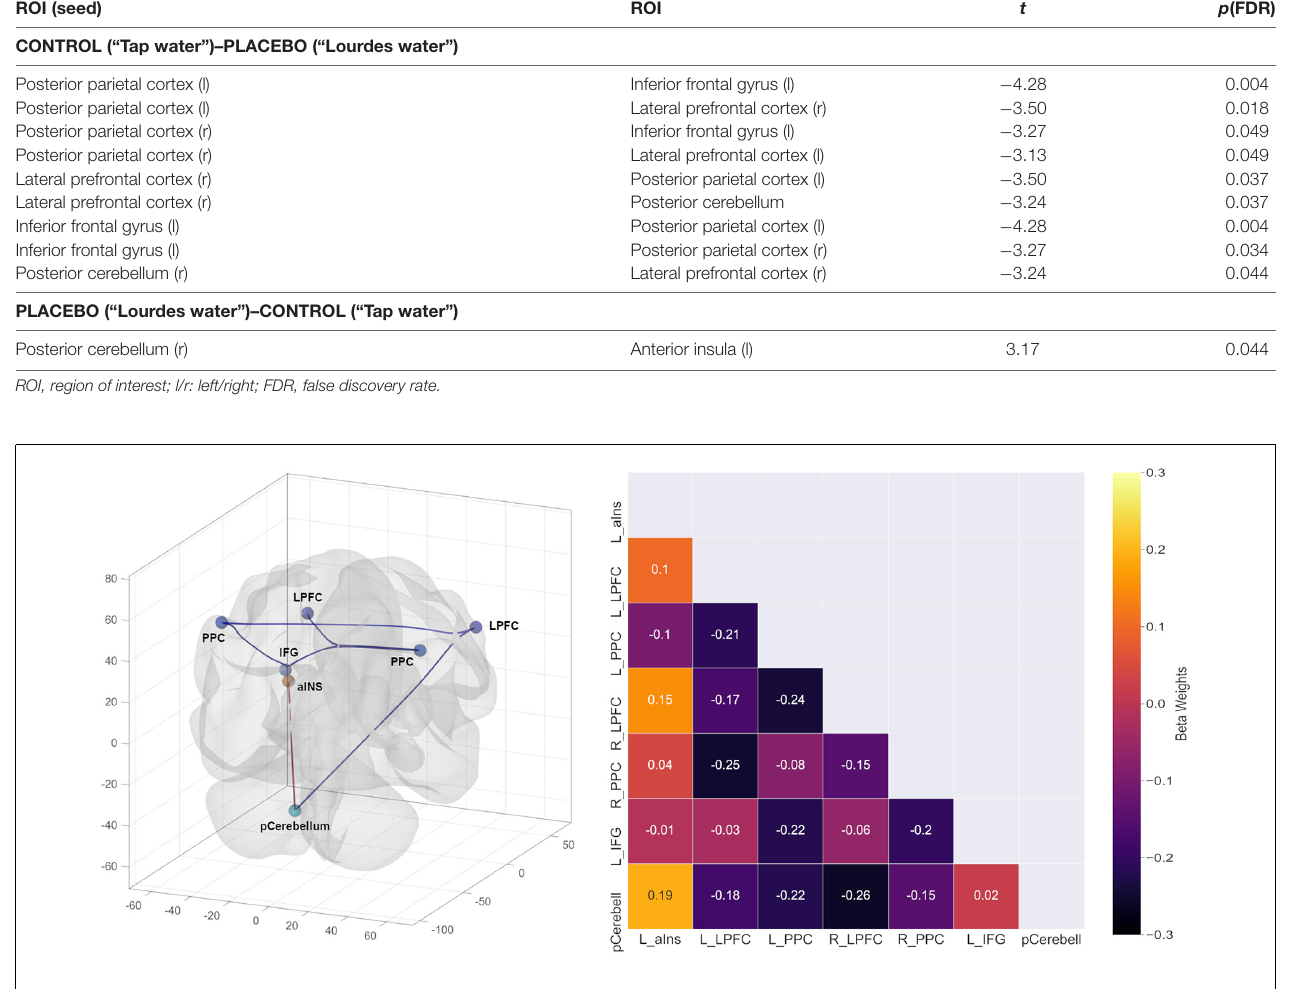
FIGURE 1 | Results of the resting-state functional connectivity analysis.